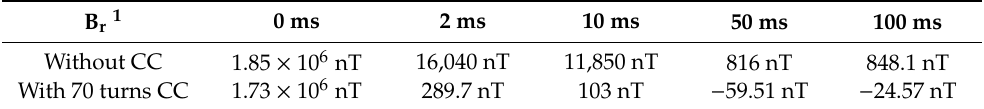
Table 2. B r without CC and with 70 turns CC at di ff erent